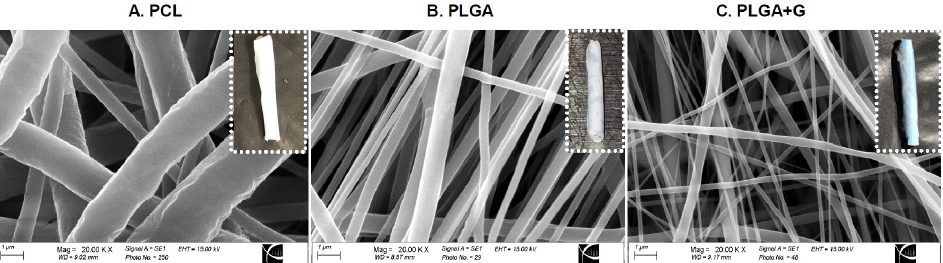
Figure 1. Scanning electron micrographs (SEM) demonstrate the fibrous architecture of electrospun PCL, PLGA and PLGA + G scaffolds. Fibers were continuous and randomly oriented. Macroscopic inserts illustrate the scaffolds rolled around the nylon catheter prior to subcutaneous implantation.